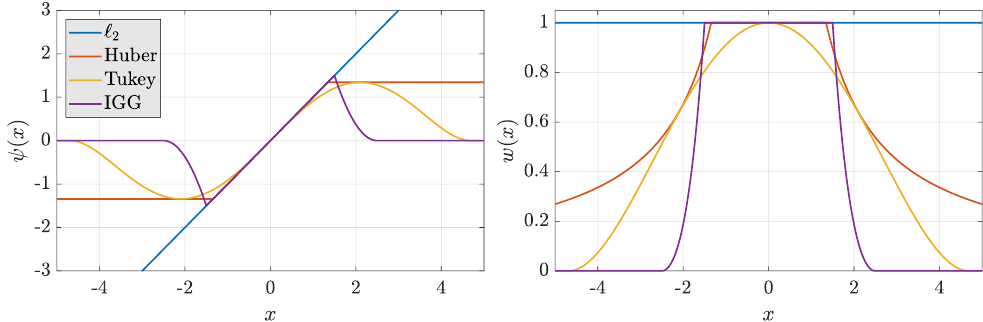
Figure 2. Illustration of the score ( left ) and weighting ( right ) functions for conventional LS ( (cid:96) 2 ) and robust estimators: here, the families of Huber, Tukey, and IGG functions are depicted with parameters a = 1.345 and c = 4.685, k 0 = 1.5, and k 1 = 2.5